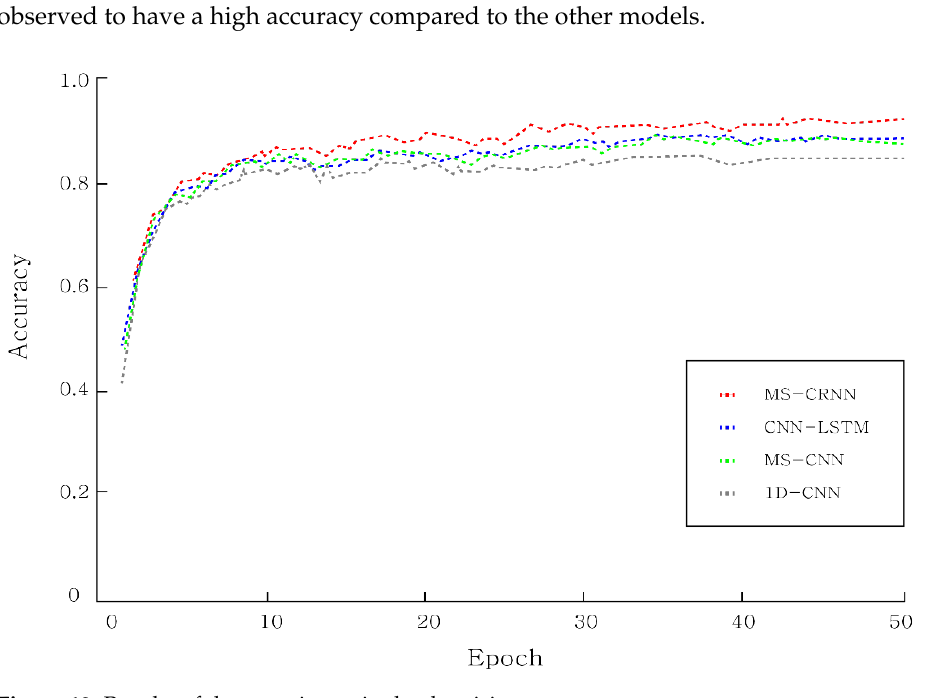
Figure 11. Confusion matrix of the proposed DAE + MS-CRNN model.